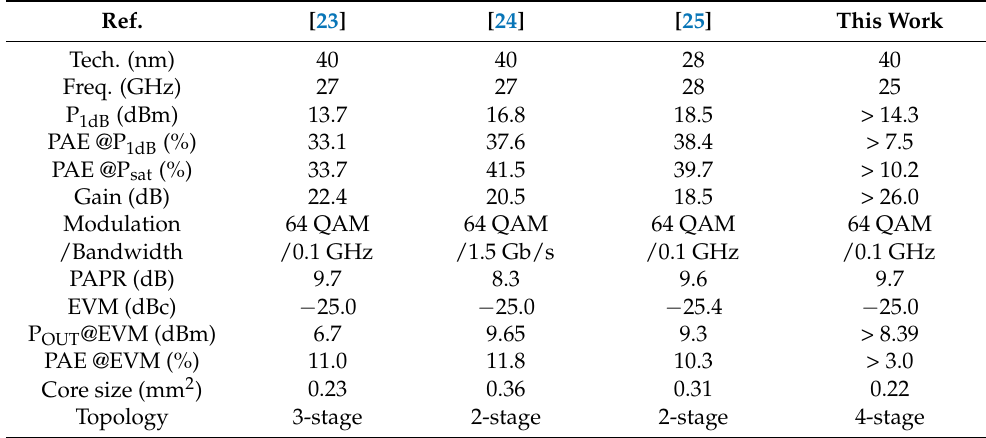
Table 1. Comparison with state-of-the-art of CMOS